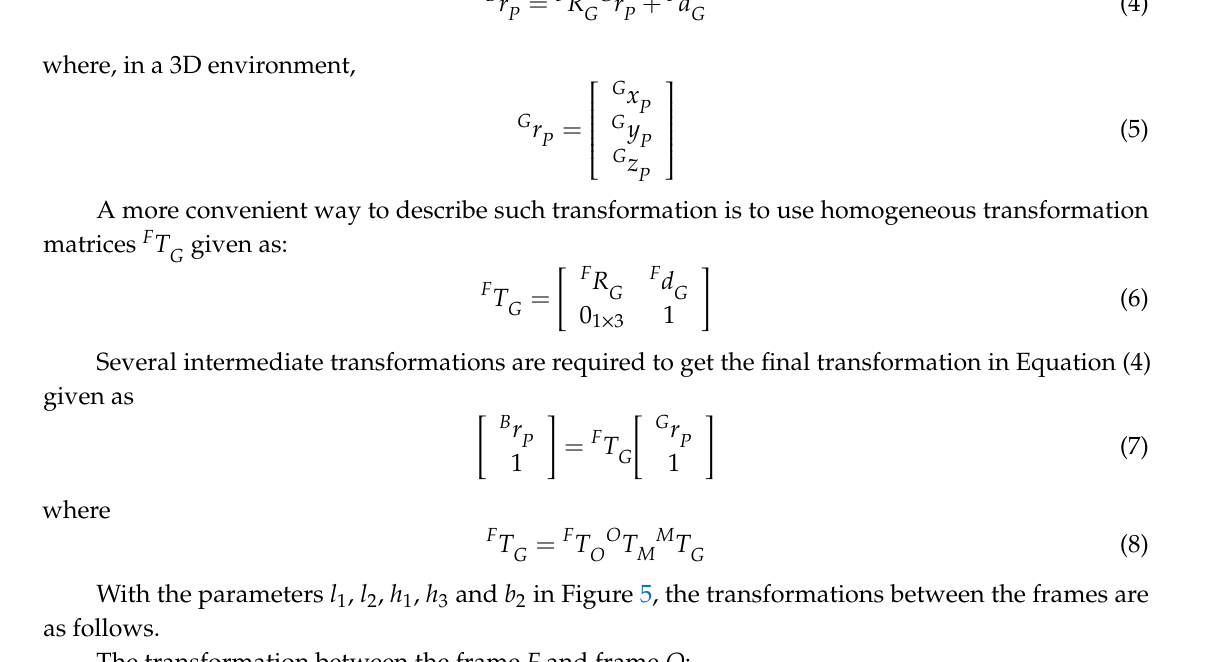
,  ,  ) = (0, 0, 0) viewed from the side and the front with Y R P